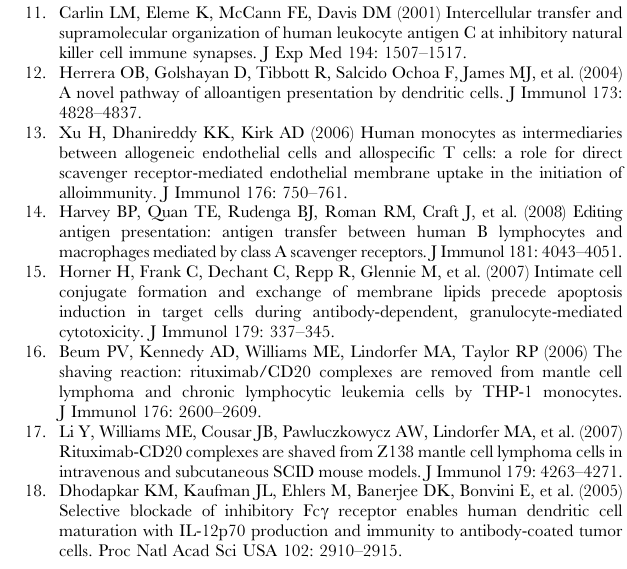
(TIF) Figure S2 Presence of CD8 + cells in the granulocyte sample. This data corresponded to Figure 2A. (TIF) Figure S3 FSC/SSC profiles of the co-culture experiments of PMNs and T cells. These data corresponded to Figure 2C. The R1 gate in the left panel represented the characteristic profile of single-cell PMNs. In the mixed culture of PMNs and T cells (right panel), the cells with the identical FSC/SSC profile of single-cell PMNs (within the R1 gate) were included in the assay. (TIF) Figure S4 Correlation between the rates of CD8 + gran- ulocytes and serum concentrations of HAMA. Statistical analysis revealed no significant correlation between the two.